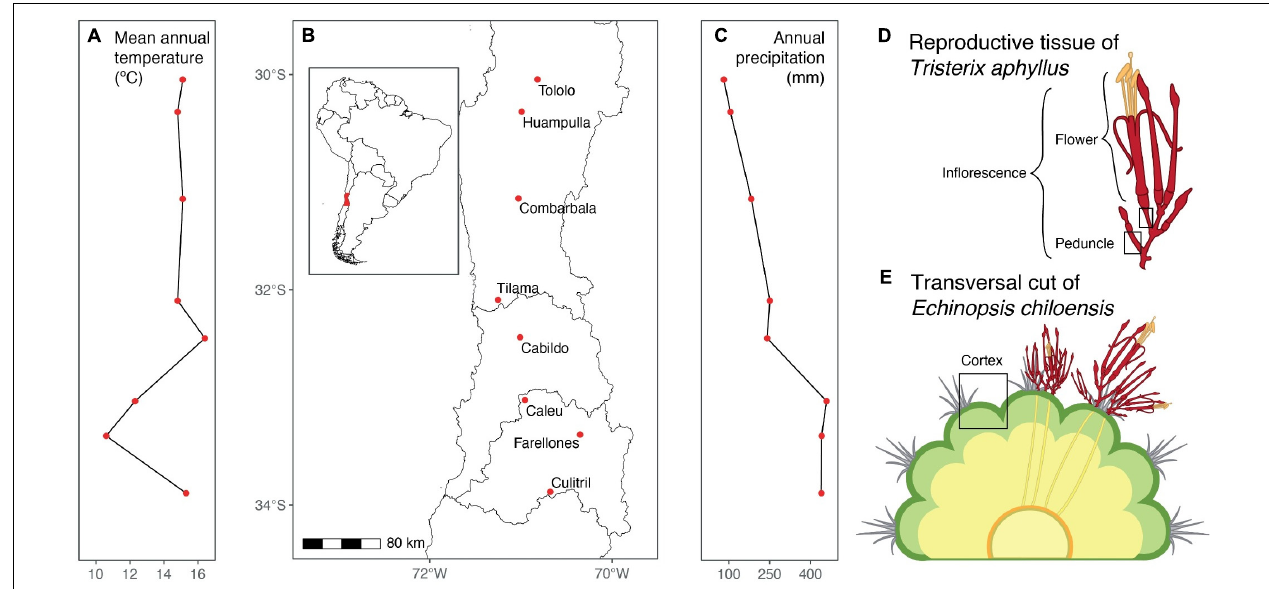
FIGURE 1 | Spatial range studied of the interaction of the holoparasite Tristerix aphyllus with its host Echinopsis chiloensis and its general climatic conditions. (A) Mean annual temperature per population, (B) map of the analyzed populations, (C) annual precipitation per population, (D) diagram of Tristerix aphyllus inflorescence, and (E) diagram of a cross section of Echinopsis chiloensis infected by T.